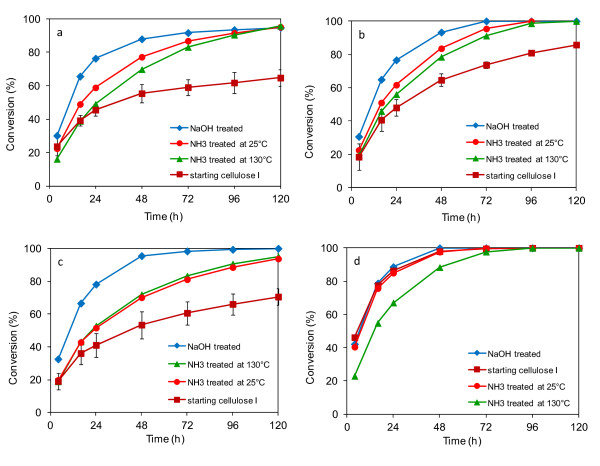
Enzymatic hydrolysis of different cellulose samples. (a) Avicel PH 101, (b) α-cellulose, (c) cotton linters, (d) corn stover cellulose. (The error bars indicate the reproducibility (± 1 standard deviation) of digestions conducted in triplicate on the Avicel cellulose samples).